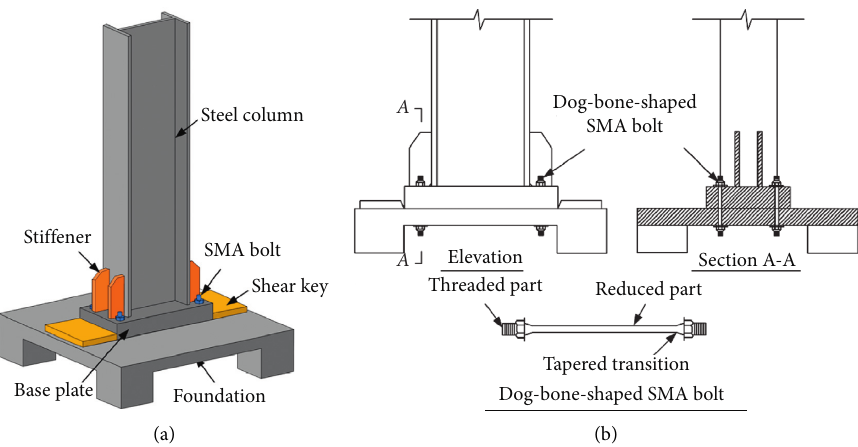
Figure 13: Steel column base details: (a) three-dimensional view; (b) elevation and section views, as well as SMA bolt (adapted from